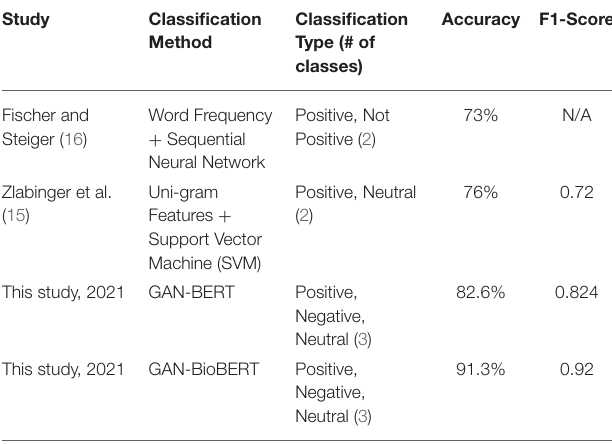
TABLE 2 | Performance metric results for both this study and previous studies.